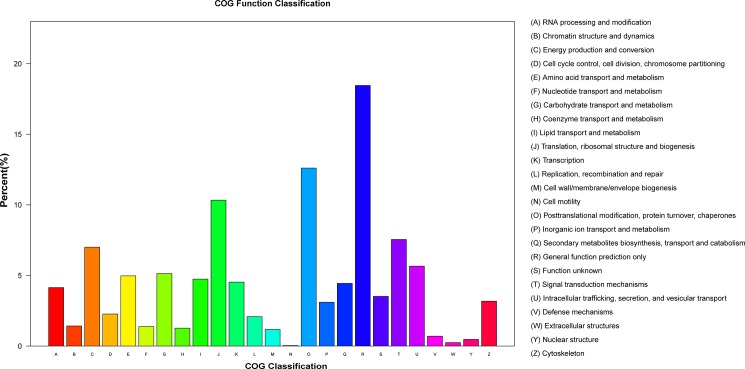
Distribution of genes in the transcriptome with COG functional classification.A total of 19129 sequences have a COG classification among 25 categories.